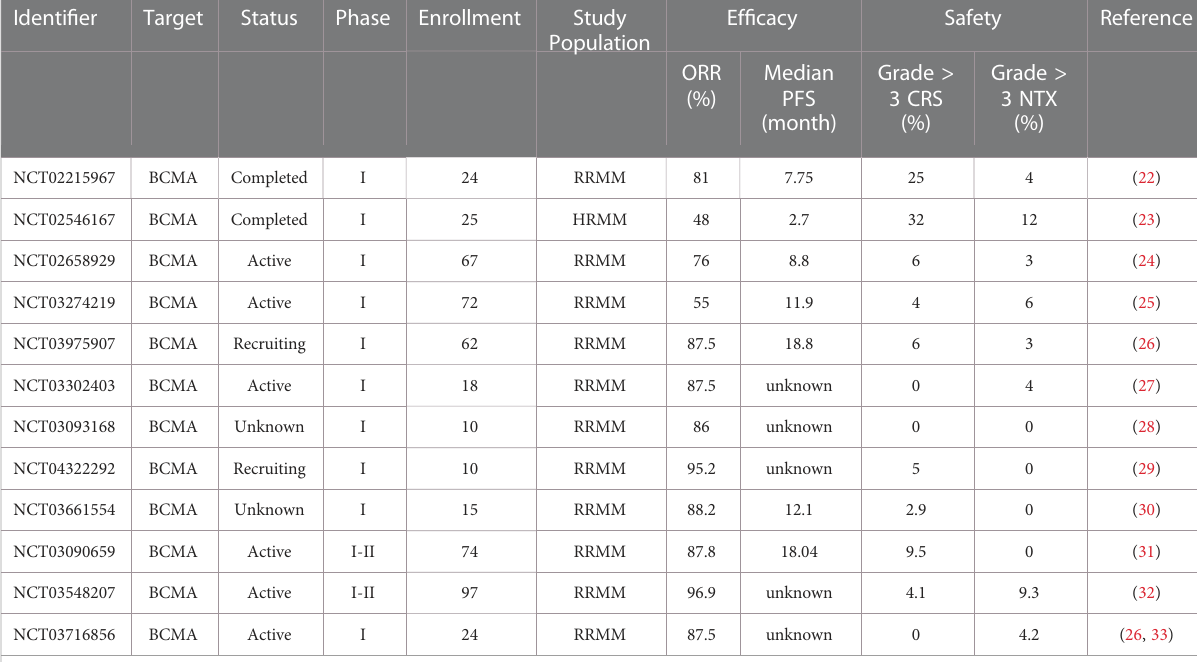
TABLE 1 Selected BCMA-targeted CAR-T clinical trials for MM.